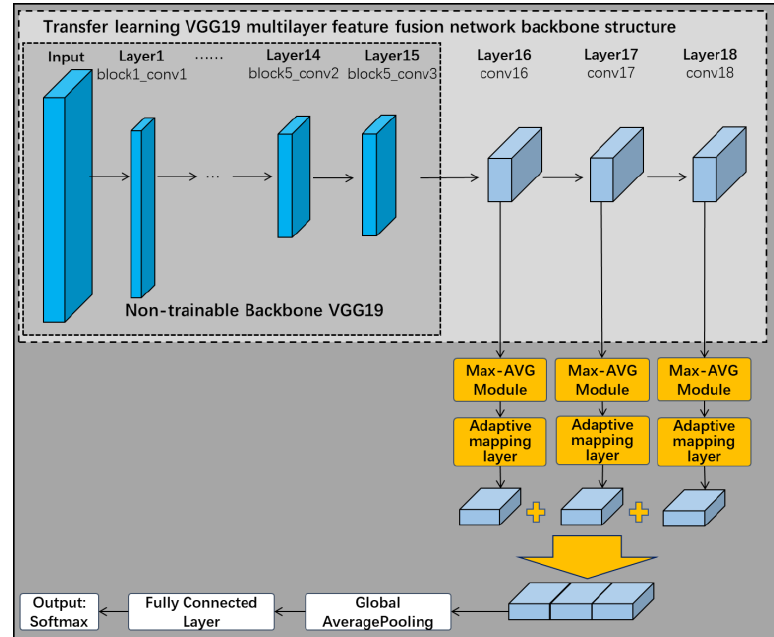
Figure 12. Max-AVG pooling multilayer feature fusion